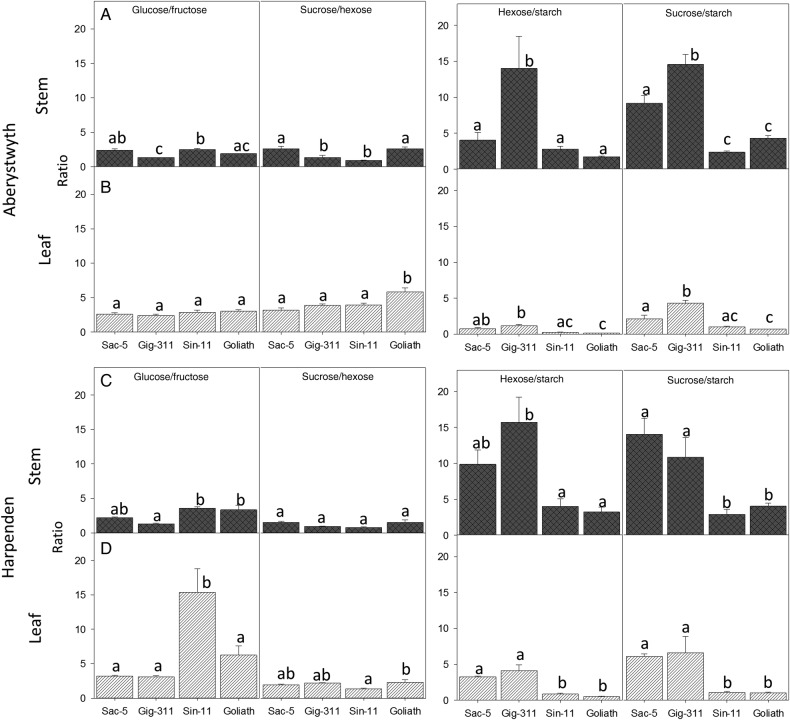
(A–D) The ratio of different pools of carbohydrate partitioned between the stem (A and C) and the leaf (B and D) at Aberystwyth (A and B) and Harpenden (C and D). Data are the average of 2011 and 2012 levels for Aberystwyth and 2012 for Harpenden. N = 8 at Aberystwyth and N = 3–4 at Harpenden ±SE. Different letters above the bars show significant differences (Tukey's HSD test P ≤ 0.05).